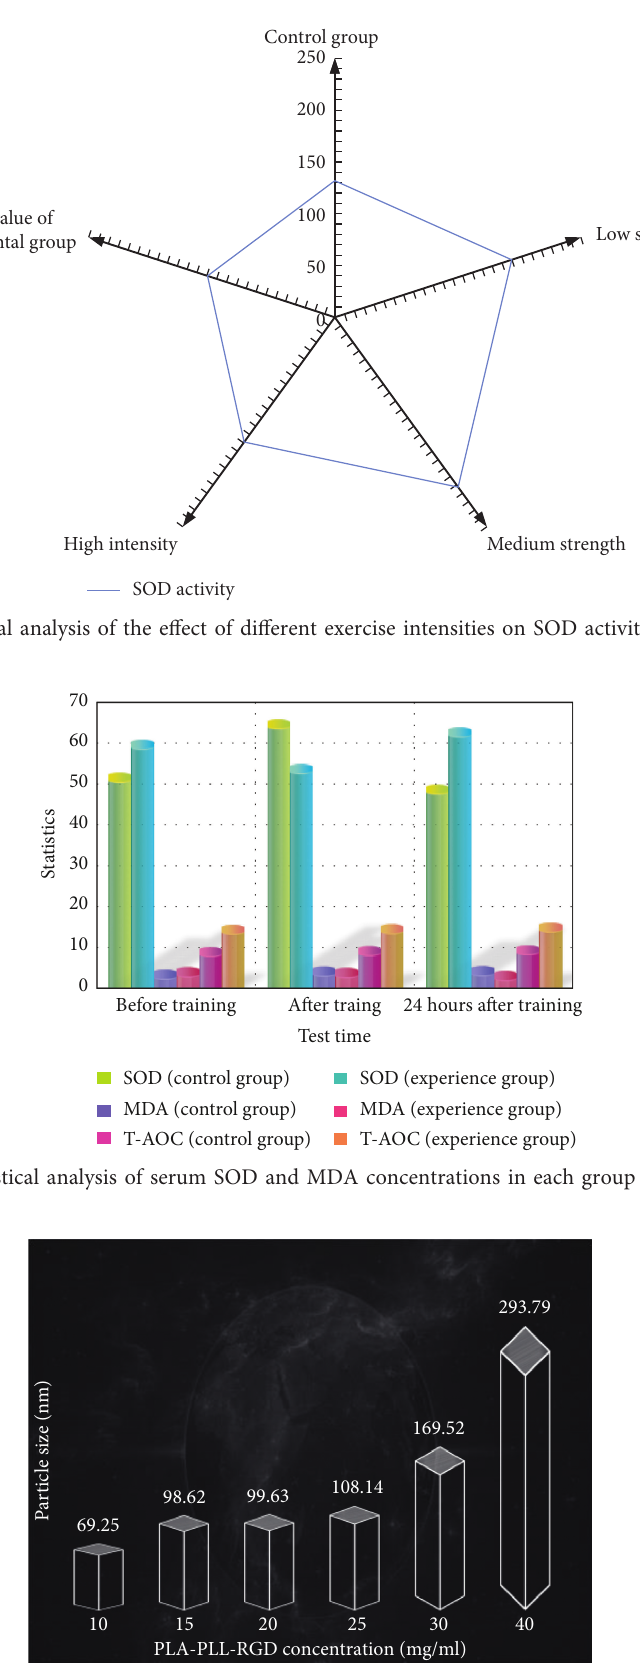
Figure 3: Statistical analysis of the effect of pla-pll-rgd concentration on SOD activity.